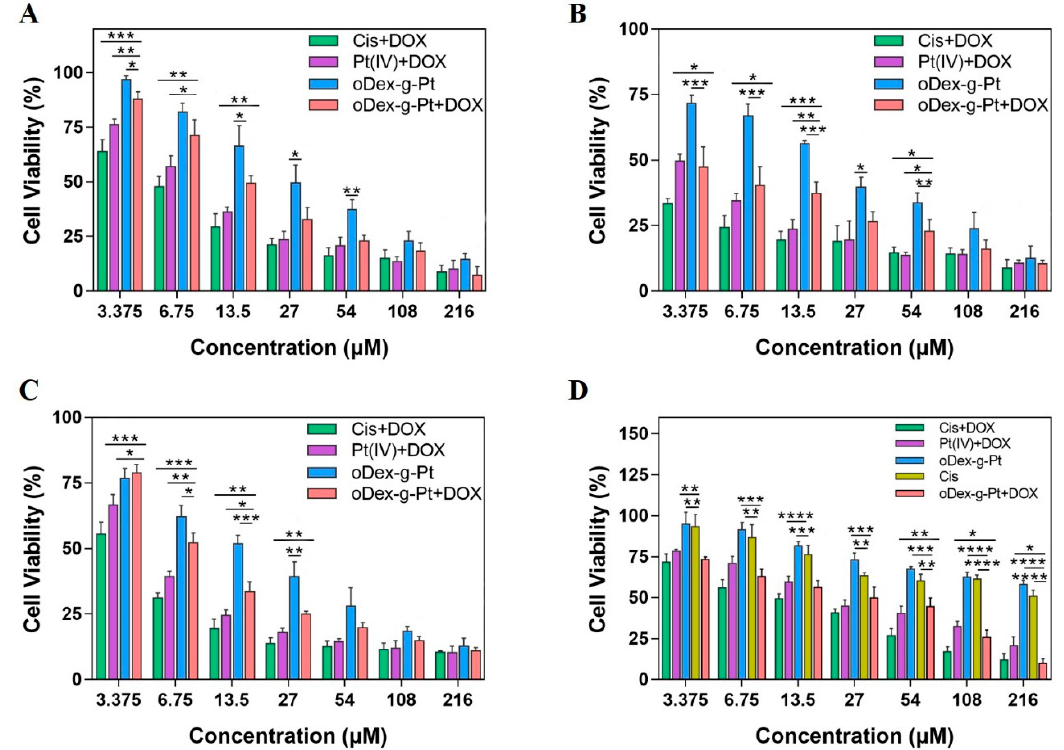
Figure 6. In vitro anti-cancer efficacy of drugs and nanodrugs. Cell viability curves of HeLa cells incubated with drugs and nanodrugs for 48 h ( A ) or 72 h ( B ). Cell viability curves of A549 cells ( C ) and A549/DDP cells ( D ) after incubation with drugs and nanodrugs for 48 h. Data points represent mean ± s.d. ( n = 3) from three independent experiments. Statistical significance was calculated via one-way ANOVA analysis with a Tukey post-hoc test. * p < 0.5, ** p < 0.01, *** p < 0.001, **** p < 0.0001.